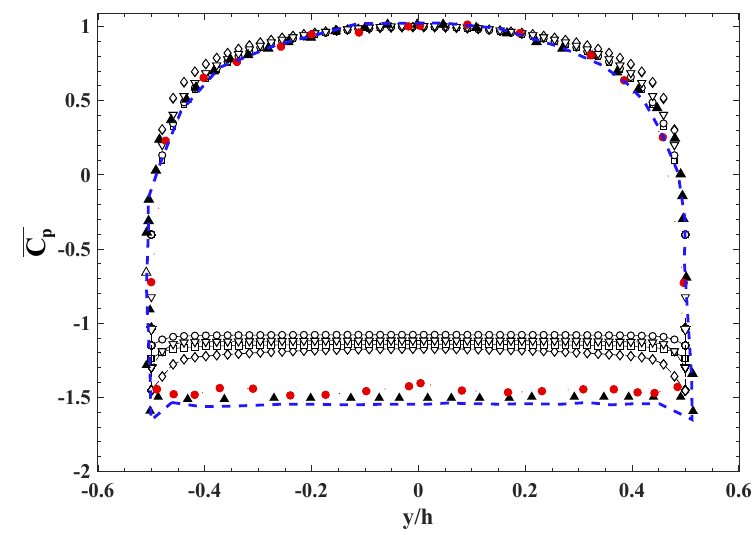
Figure 4. Comparison of mean pressure coefficients C p on the plate from [ ♦ ] SIM-1, [ (cid:3) ] SIM-2, [ ◦ ] SIM-3, [ (cid:79) ] SIM-4, [ (cid:78) ] DNS [29], [ • ] Experiments at Re = 1.5 × 10 5 [7] and [ −− ] DNS at Re = 1000 [42].